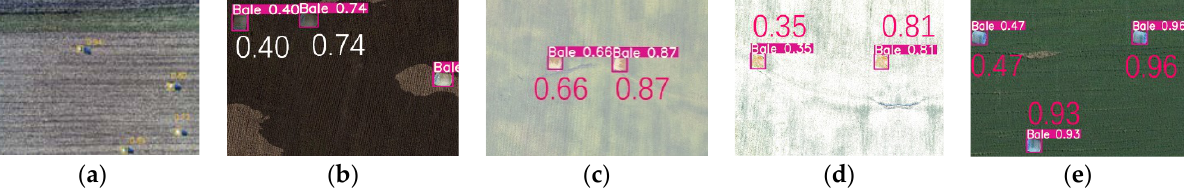
Figure 11. Examples of the tested bale images under multiple environmental conditions using our framework (YOLOv3 + DA): ( a ) initial condition with good illumination and no shadow in fall; ( b ) extended condition — early winter with shadow; ( c ) summer with haze; ( d ) winter with snow cover; ( e ) summer with good illumination conditions.